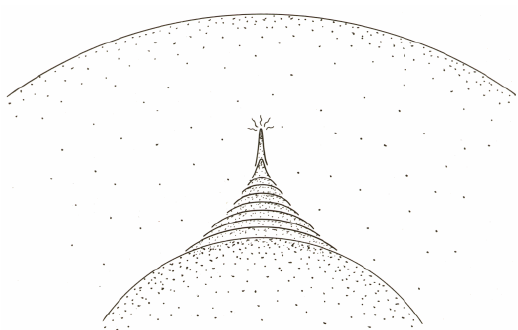
Figure 3. Consider a current sheet inside the Earth and a minor bump with respect to perfect spherical symmetry. Owing to Hamilton’s, the currents concentrate at the top of the bump, where Joule heat is released. The thermal conductivity is very low. The local temperature increases, and thus also the local electrical conductivity σ . Owing to Hamilton’s, additional currents penetrate upward. The process is thus self-amplifying. In terms of the mass density, the Earth looks like an onion, and in terms of σ , like a “sea urchin” or an ‘‘octopus’’. Heat propagation implies no transport of matter (no magma, no ions, etc.), rather only of electrons. The process is electrodynamic, not thermodynamic. After Gregori (1993, 2002)